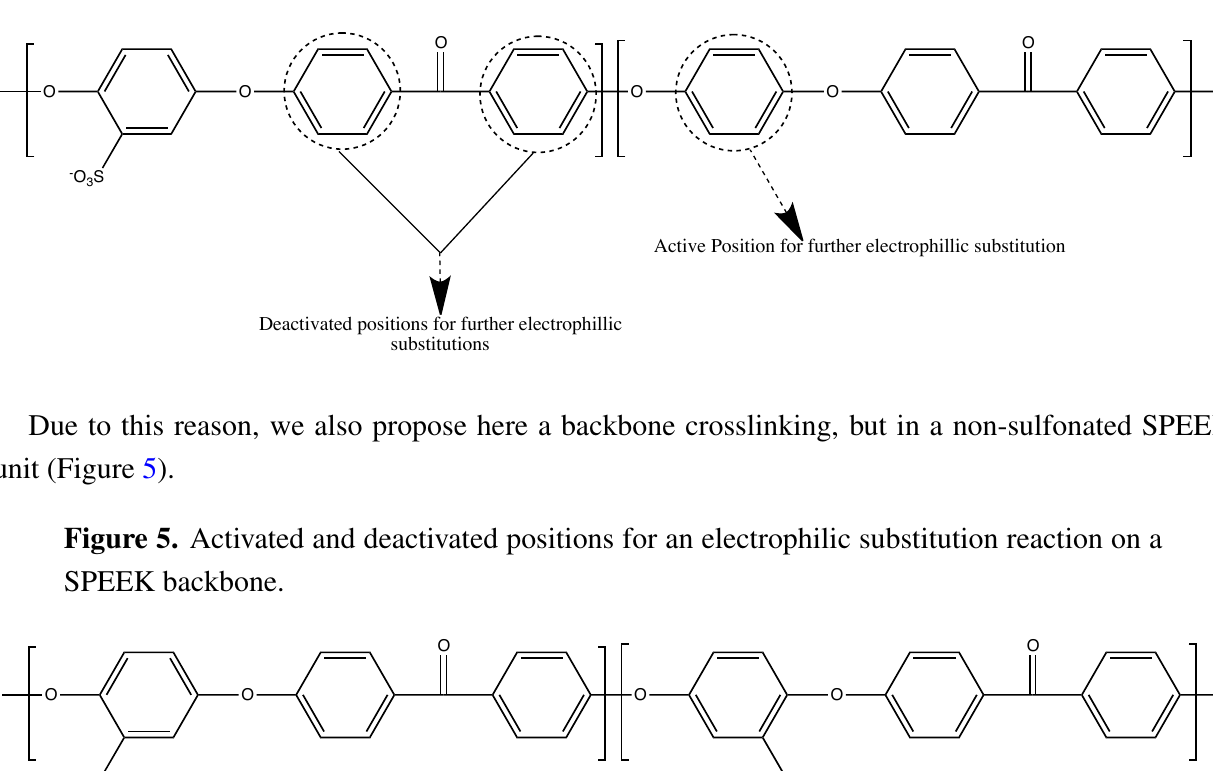
Figure 4. Activated and deactivated positions for an electrophilic substitution reaction on a SPEEK backbone.